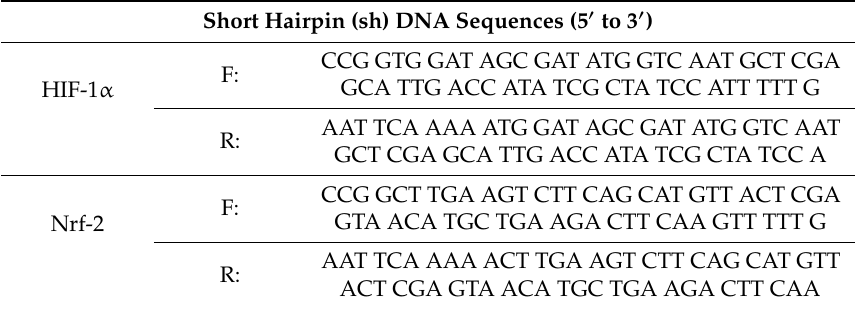
Table 1. Murine HIF-1 α and Nrf-2 short hairpin (sh) DNA